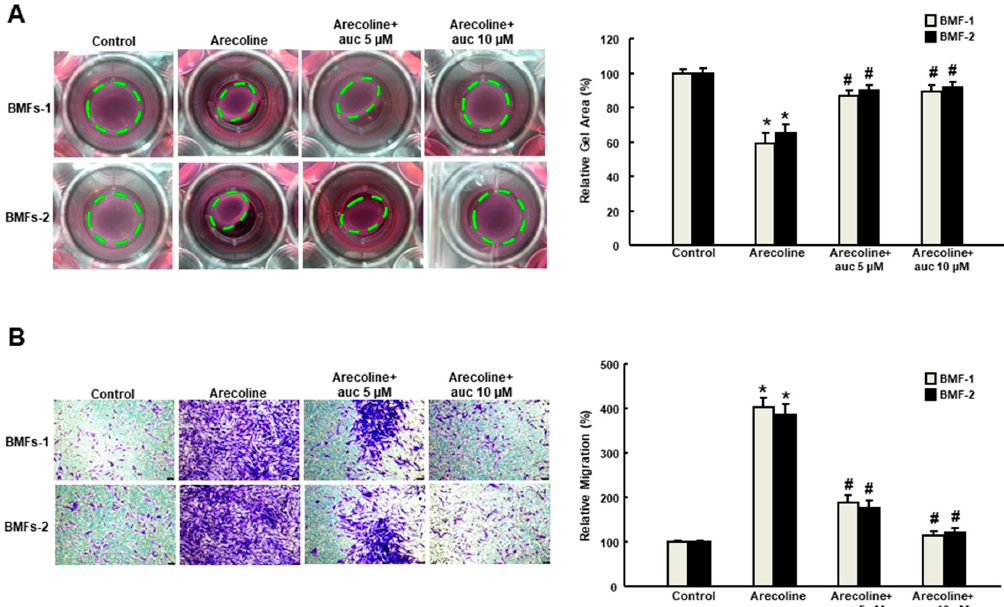
Figure 2. Arctigenin inhibits the arecoline-induced collagen contraction and migration capacities of BMF. ( A ) Arecoline-treated BMFs with or without arctigenin were subjected to collagen gel contraction assay (three replicates for each concentration). The gel areas (dotted circles) were calculated using ImageJ software. Representative images are presented; ( B ) Cell migration was measured 48 hours post-arctigenin exposure in arecoline-stimulated BMFs. * p < 0.05 as compared with the non-arctigenin-treated group; # p < 0.05 as compared with the arecoline group. Magnification, ×100.